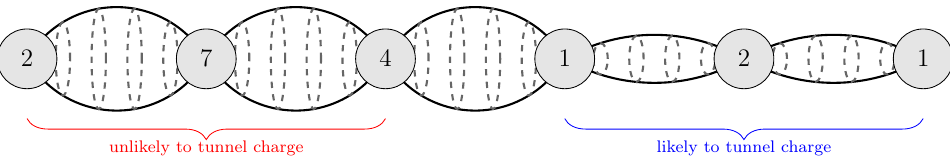
Figure 19: A cartoon of how λ (cid:29) 1 affects tunneling such that typical microstates have only a few